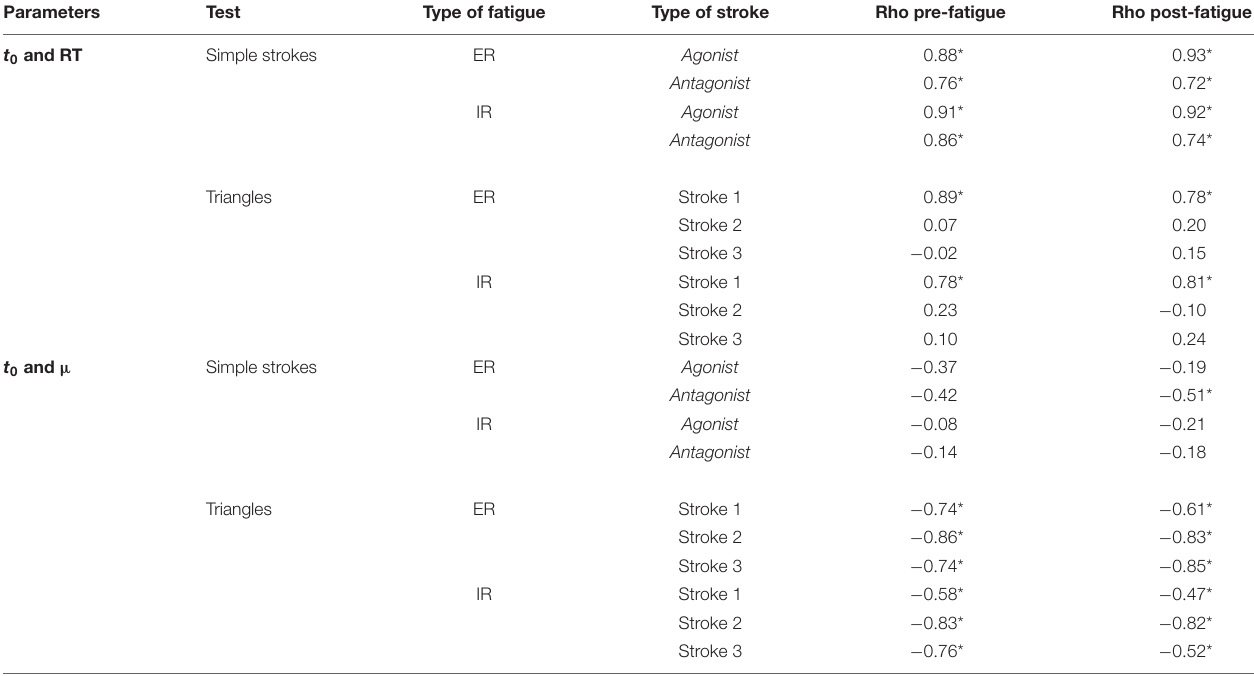
TABLE 5 | Spearman correlation coefficients between parameters, with rho-values of correlation pre- and post-fatigue. Parameters